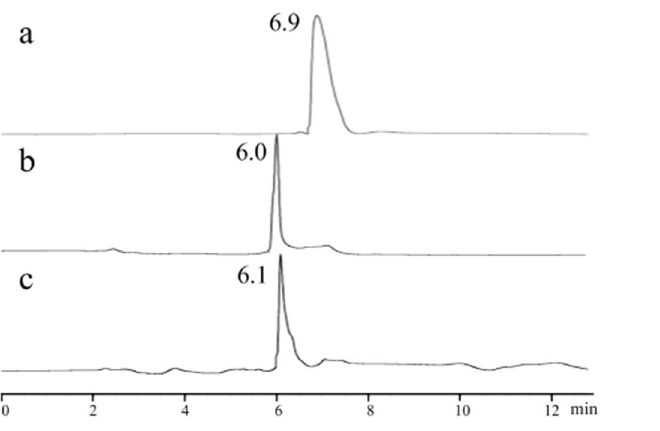
Figure 3. HPLC analysis of sophocarpine ( a ), matrine derivatives 1 ( b ) and 2 ( c